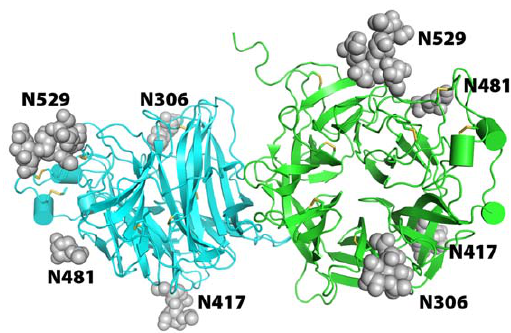
Figure 1. Structure of the HeV-G dimer. The secondary structure elements of the two molecules are colored in cyan and green. The axes of the two six-blade b -propellers are approximately perpendicular to each other. Disulfide bonds are illustrated as yellow sticks. Asparagine- linked carbohydrate modifications (glycosylations) are illustrated as grey